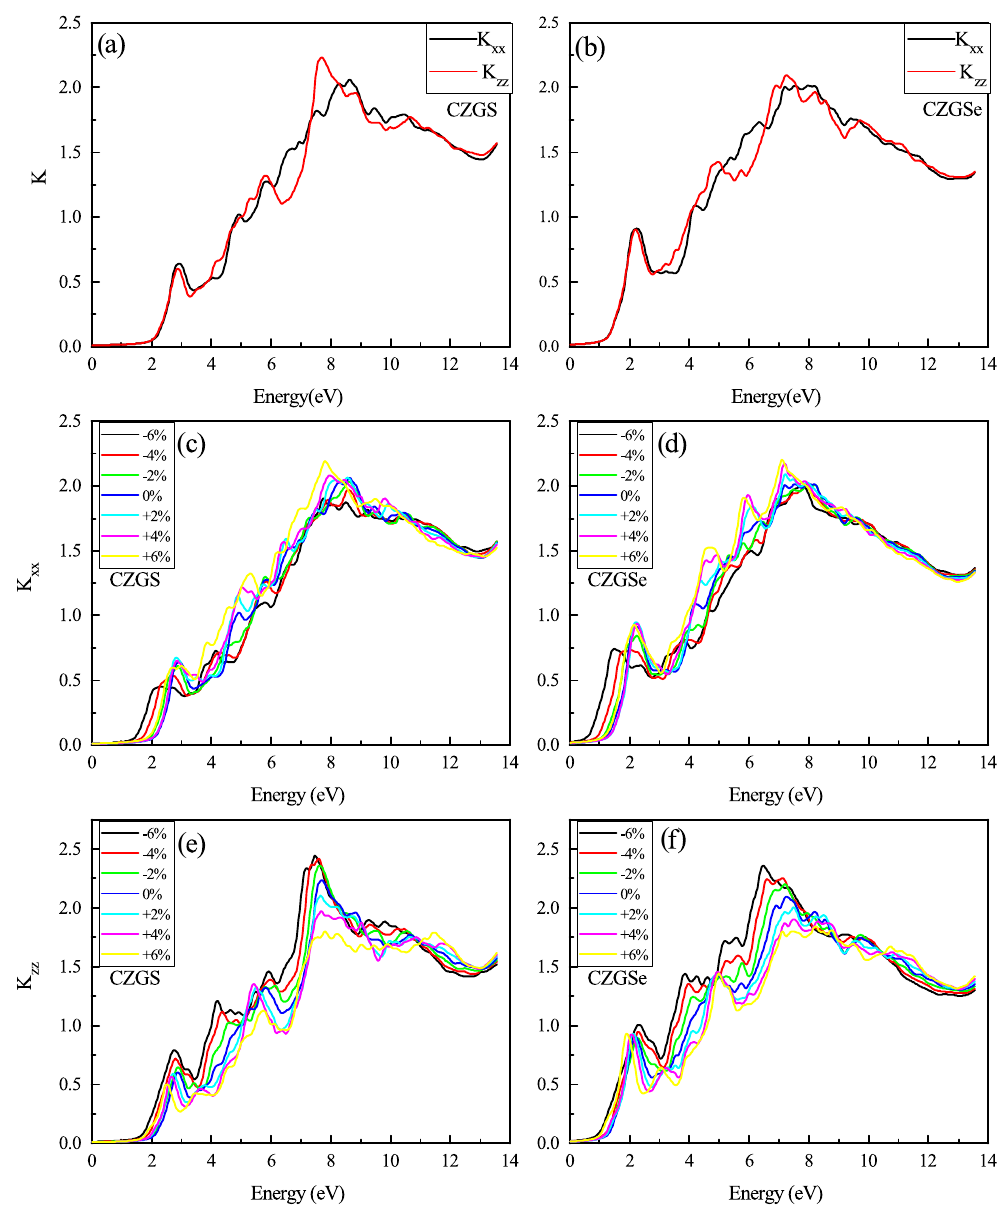
Figure 13. The variation of the extinction coefficient spectra as a function of the incident photon energy for both materials CZGS and CZGSe: ( a , b ) are the unstrained cases, ( c – f ) are the strained cases. K xx and K zz are the extinction coefficient for light polarization along XX and ZZ directions